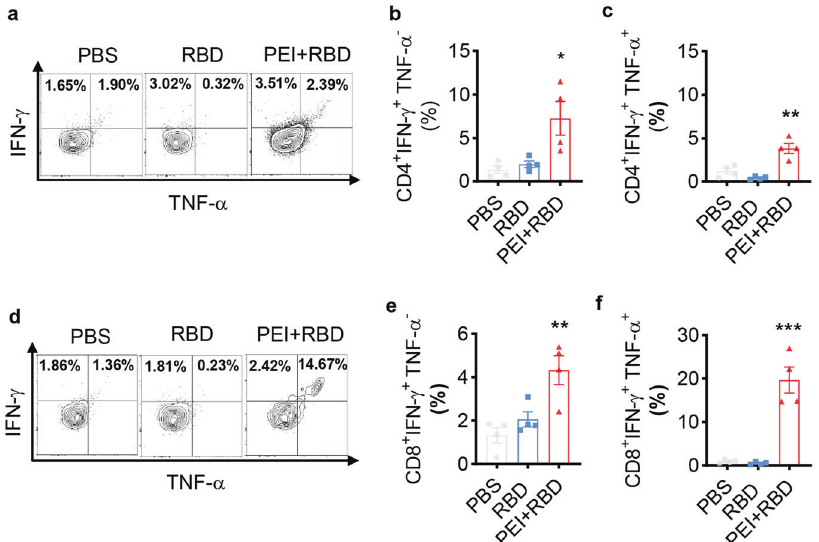
Fig. 4 Intranasal immunization with adjuvanted RBD vaccine increases the frequency of long-lasting functional T cells in the lungs. NIH mice were intranasally immunized with PBS, RBD and PEI-adjuvanted RBD vaccine on days 0, 7, and 21. On day 365, immunized mice were sacri fi ced and lung tissues were harvested. The production of IFN- γ and TNF- α cytokines by lung T cells were assessed by FCM . a Representative FCM plots of IFN- γ and TNF- α expression in lung CD4 + T cells. Quanti fi cation of lung CD4 + IFN- γ + TNF- α − ( b ) and CD4 + IFN- γ + TNF- α + ( c ) T cells. d Representative FCM plots of IFN- γ and TNF- α expression in lung CD8 + T cells. Quanti fi cation of lung CD8 + IFN- γ + TNF- α − ( e ) and CD8 + IFN- γ + TNF- α + ( f ) T cells. All the data were presented as mean ± SEM. n = 4. P values were compared to PBS group (* P < 0.05; ** P < 0.01; *** P < 0.001)